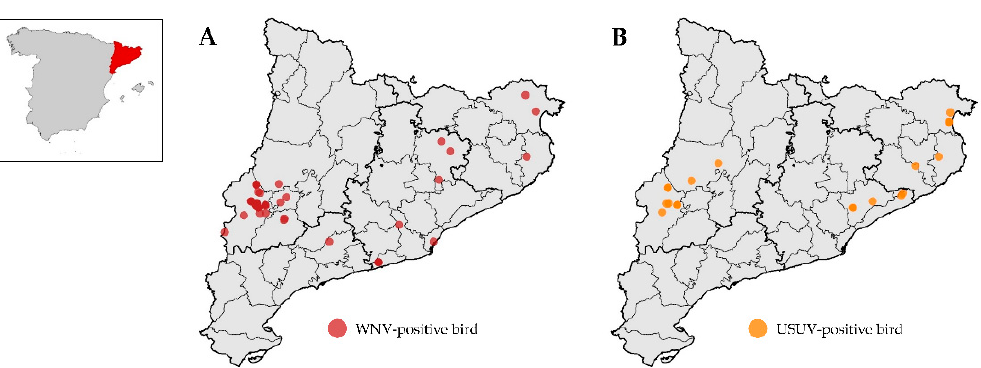
Figure 1. Distribution of WNV-positive birds ( A ) and USUV-positive birds ( B ). The geographical units within Catalonia are the 42 comarques. On the left, location of Catalonia (in red) within Spain. The 118 birds infected by WNV in Catalonia belonged to 14 species and six families.